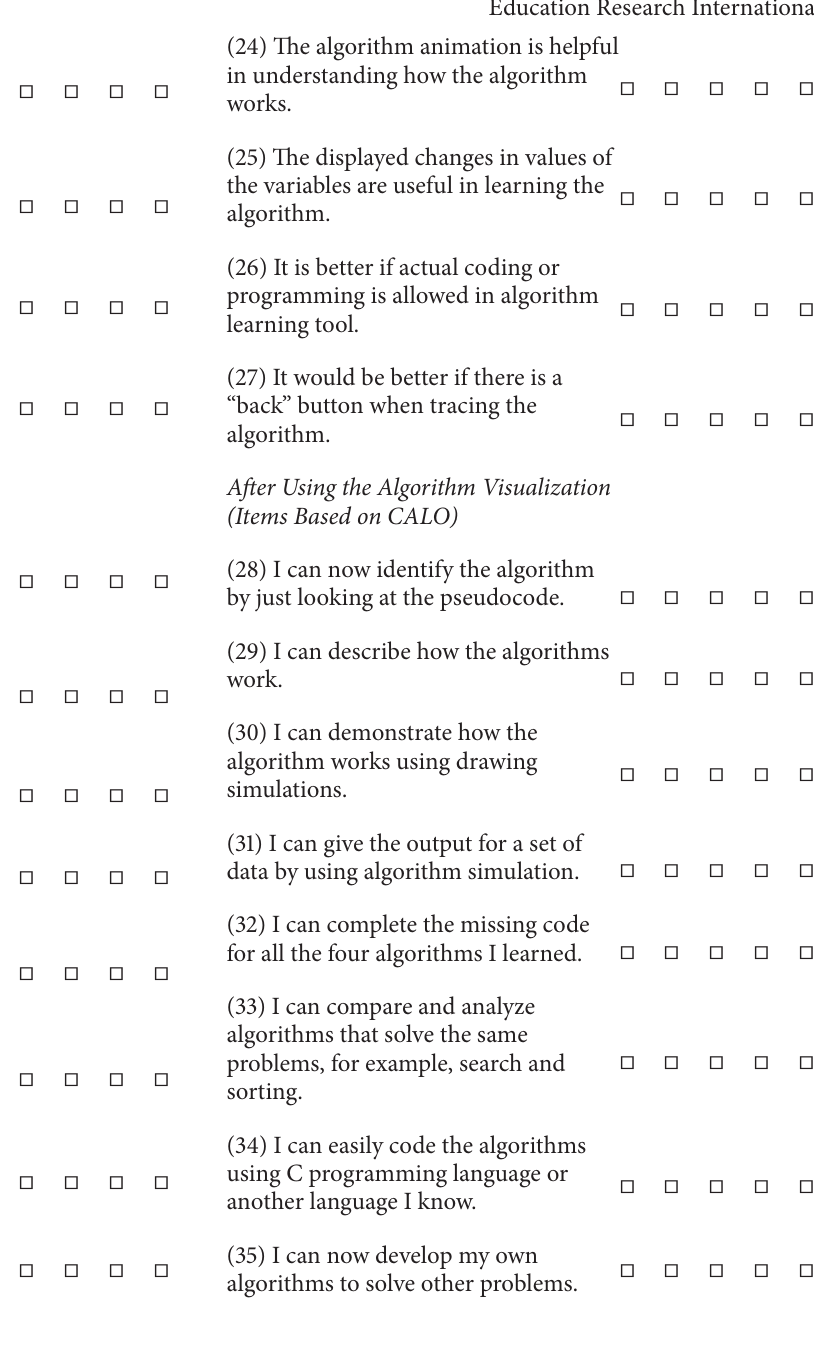
Algorithm Visualization’s Characteristics